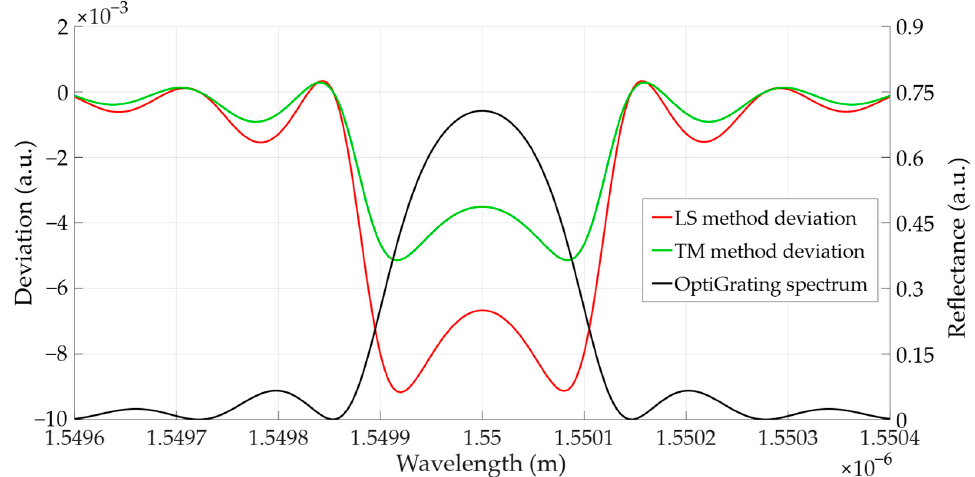
Figure 5. Deviations of the homogeneous FBG spectra from the reference (OptiGrating) spectrum (left axis): deviation of the Layer Sweep method (red line), deviation of the Transfer Matrix method (green line), reference OptiGrating spectrum (black line, right axis).